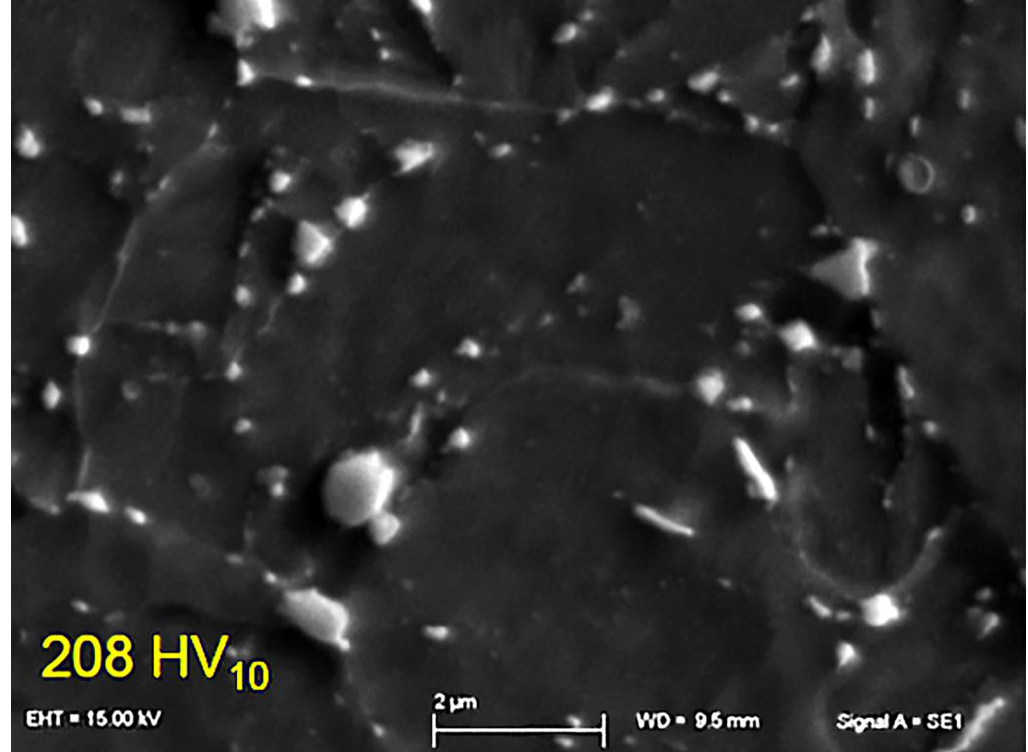
Figure 2. Microstructural and precipitate SEM analyses of GR 91 interrupted after 4000 h (total ageing 50,334 h at 650 °C).